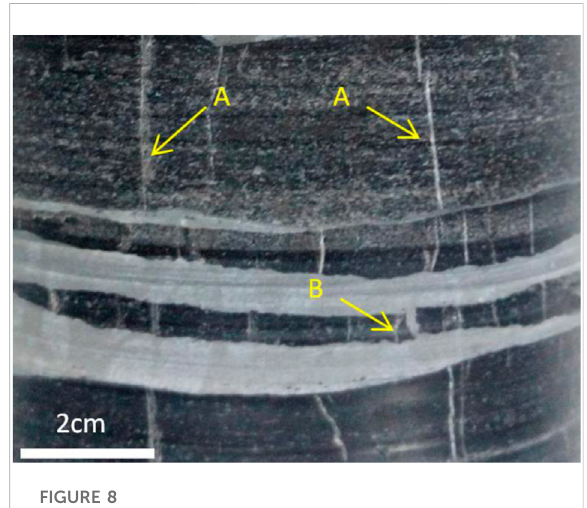
FIGURE 8 Surface fracture morphology of banded phosphate